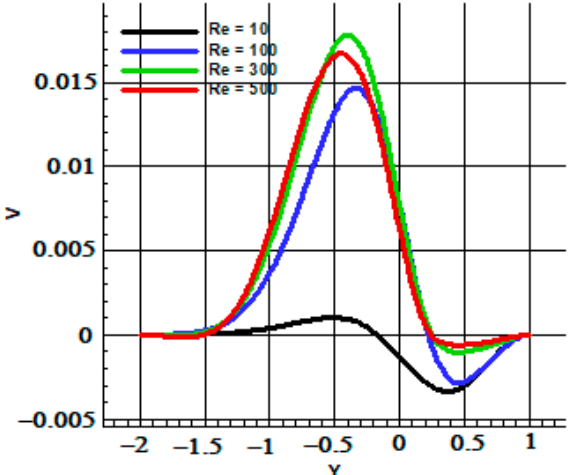
Figure 8. Y-velocity for different Re number and Pr = 6.2, Le = 1, N B = N T = 0.1.